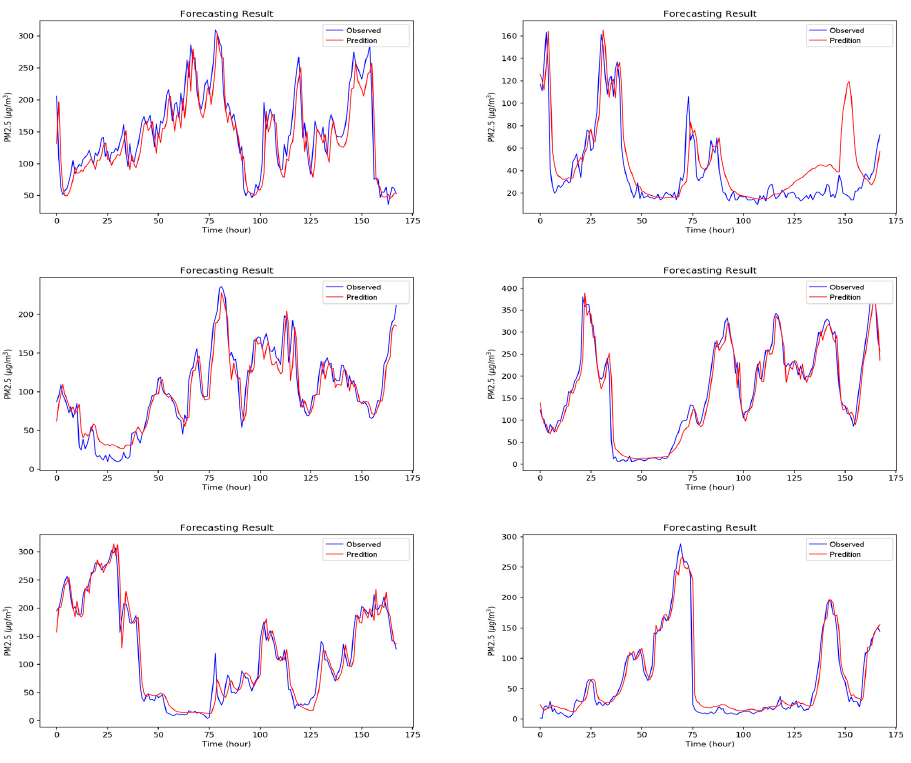
Figure A6. The forecasting results of LSTM.